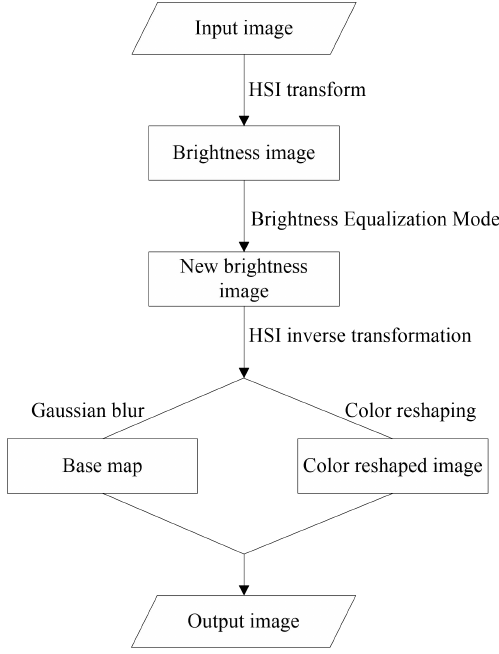
Fig.2 Flow chart of brightness equalization